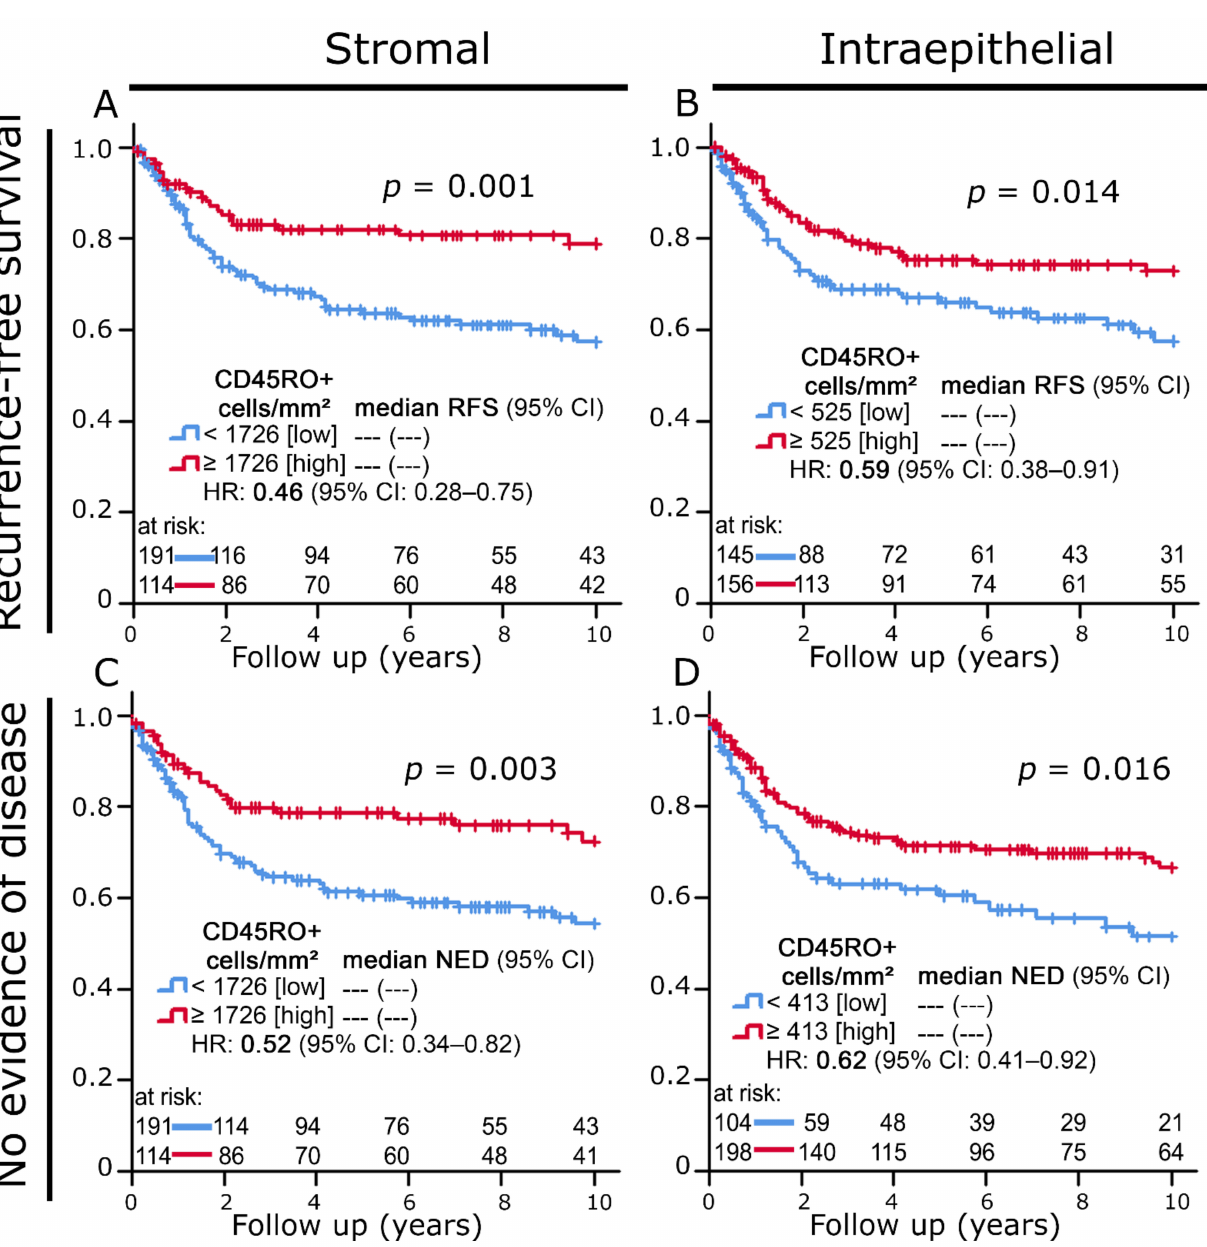
Figure 2. ( A , B ) Kaplan–Meier plots of recurrence-free survival according to CD45RO+ cell densities in the ( A ) stromal and ( B ) intraepithelial compartment. ( C , D ) Kaplan–Meier plots of no evidence of disease status according to CD45RO+ cell densities in the ( C ) stromal and ( D ) intraepithelial